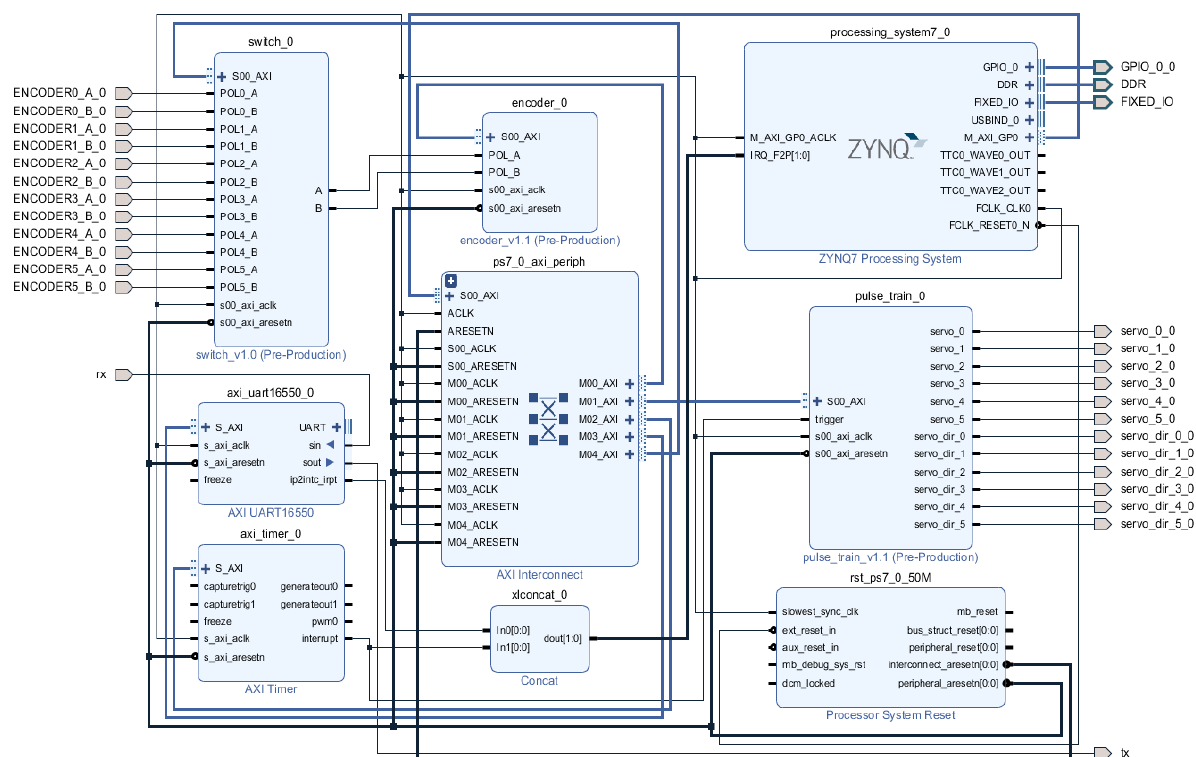
Figure 3. Block IP